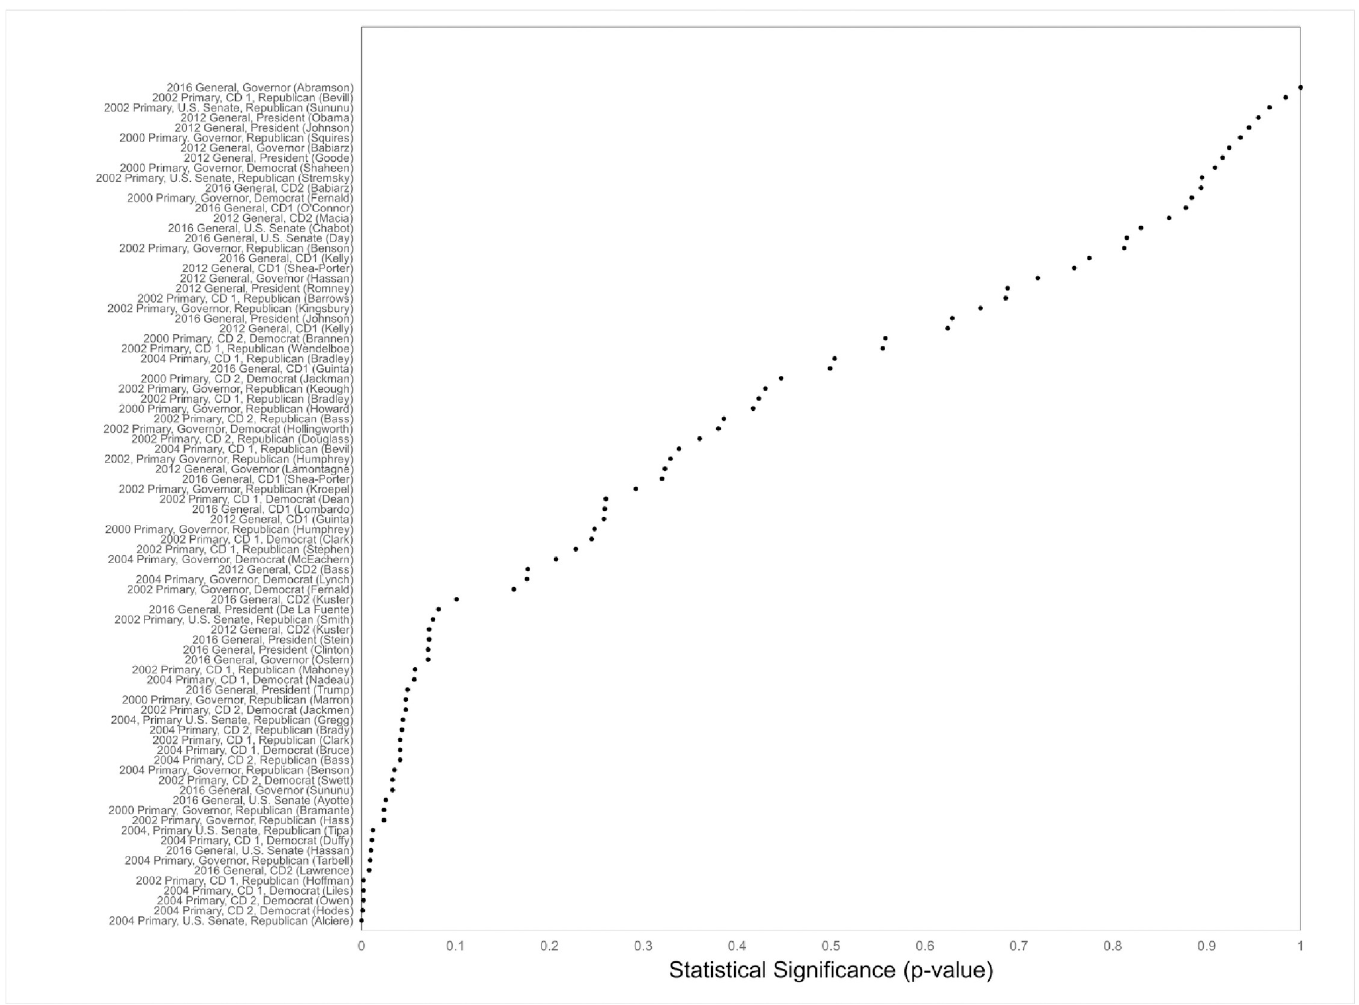
Fig 2. Statistical significance of name order effects in New Hampshire